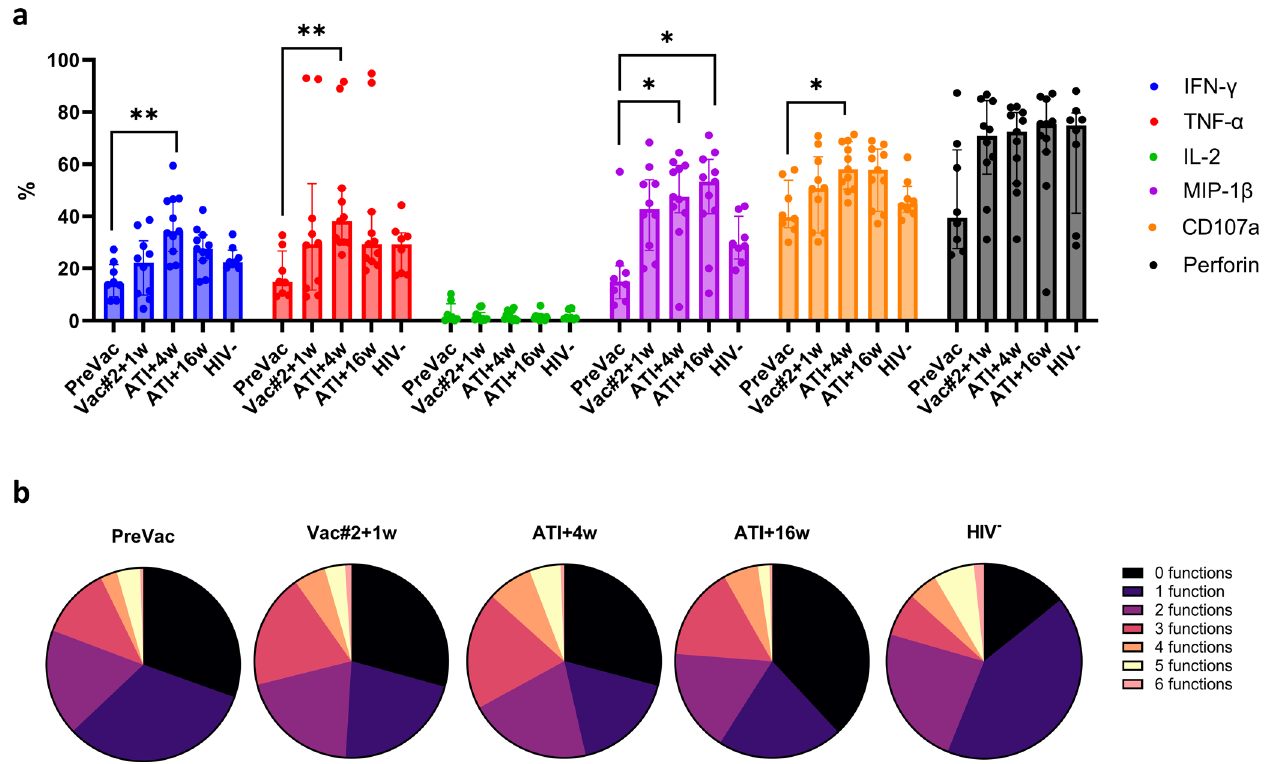
Fig. 7 ADCC-induced NK cell polyfunctionality upon DC-TRN vaccination. PBMCs from trial participants or uninfected individuals (HIV-1 − ) were incubated with CEM.NKr CCR5 + cells coated with recombinant gp120 in the presence of 1 µg/mL VRC01 for 12 h. NK cells were identi fi ed as described in Supplementary Fig. 1a and subsequent gating for intracellular markers was performed (see Supplementary Fig. 10). a Percentage of NK cells expressing the individual intracellular markers in trial participants and HIV-1 − individuals. Data are presented as median ± IQR; Kruskal – Wallis with Dunn ’ s multiple comparisons test for each marker separately. b Pie charts showing the proportion of NK cells having 0 – 6 functions. P -values <0.05 were considered statistically signi fi cant and graphically annotated as follows: * p < 0.05 and ** p < 0.005.